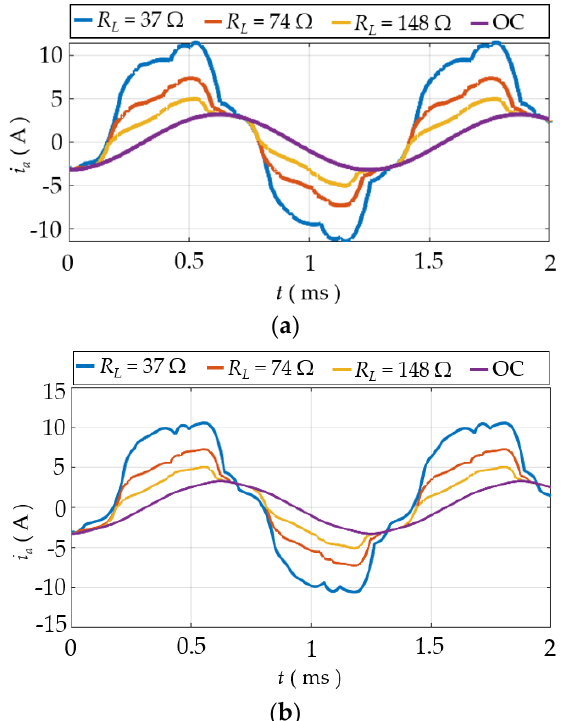
Figure 7. ATU input current waveforms. ( a ) Nominal condition. ( b ) Distorted input voltage.